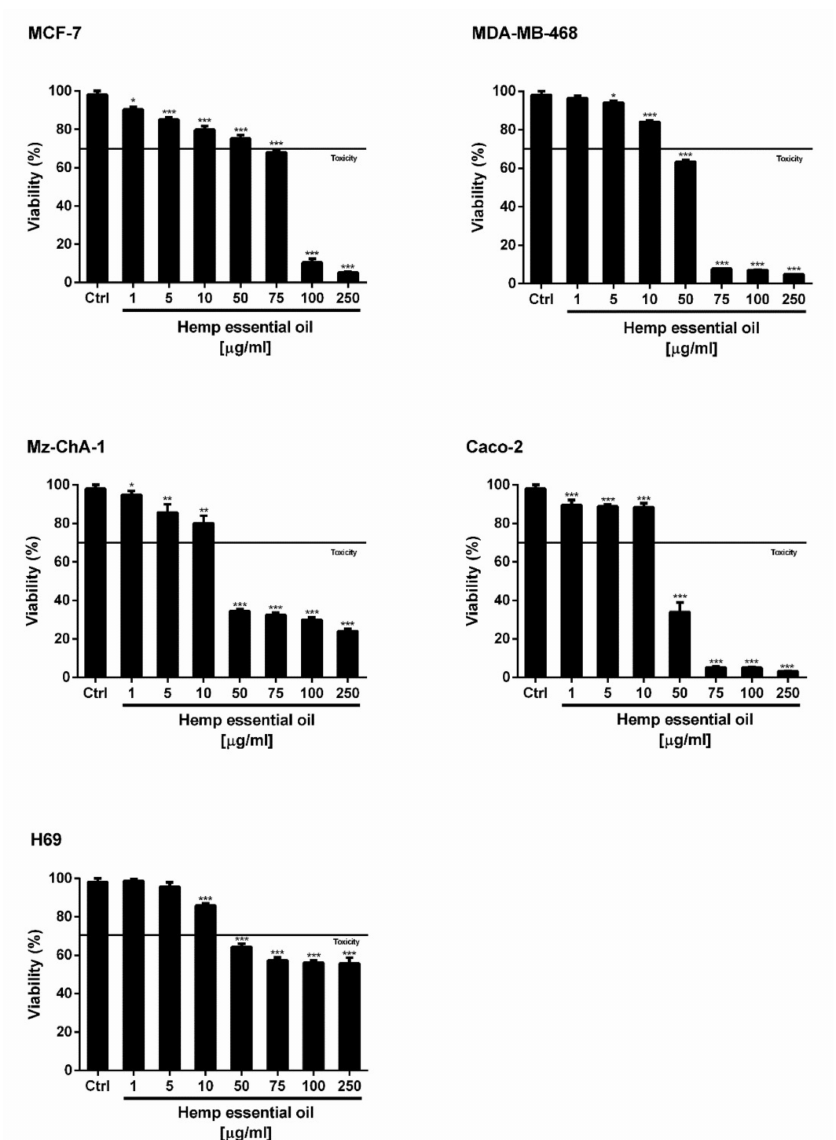
Figure 4. Cytotoxic effect of hemp EO in different human cell lines after 24 h of exposure. MCF-7, estrogen-dependent breast cancer cells; MDA-MB-468, triple-negative breast cancer cells; Caco-2, colorectal adenocarcinoma cells; Mz-ChA-1, cholangiocarcinoma cells; H69, nonmalignant immortalized cholangiocytes. Data are the mean ± SEM from almost two independent experiments with three technical replicates ( n = 6); * p < 0.05, ** p < 0.01, and *** p < 0.001 vs. control determined by ANOVA followed by Dunnett’s multiple comparison post hoc